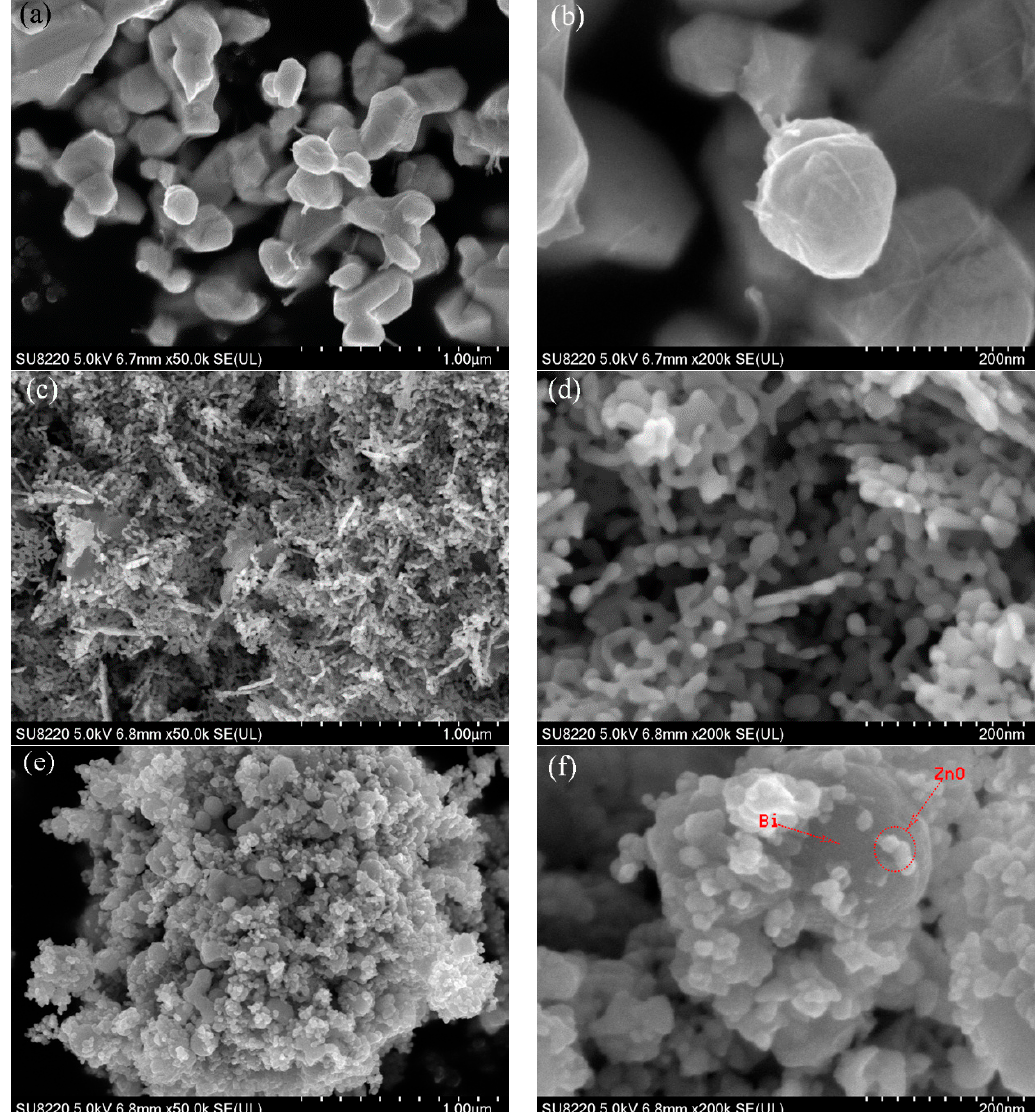
Figure 2. SEM (scanning electron microscopy) images of ( a , b ) Bi, ( c , d ) ZnO, and ( e , f ) Bi-ZnO-80.